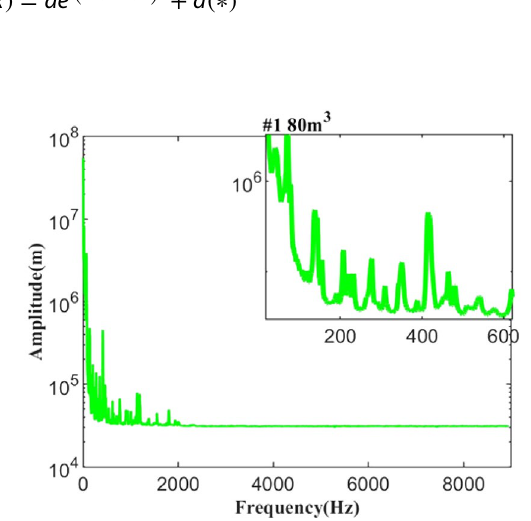
Fig. 4 #1 Comparison of spectrum